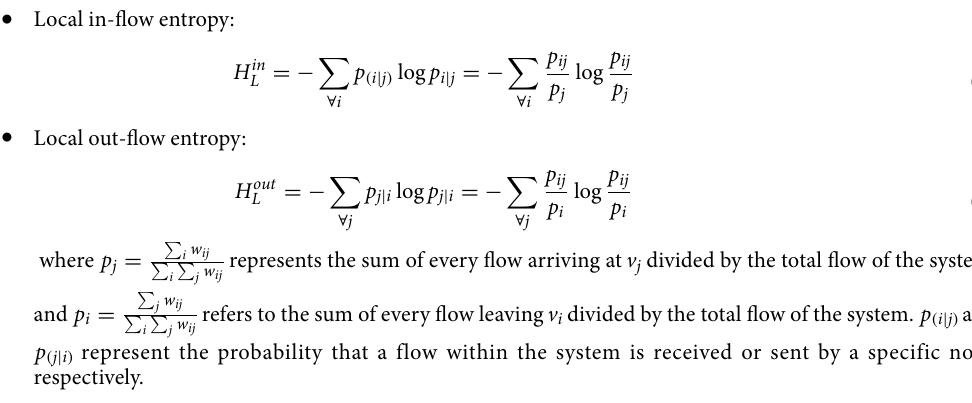
Fig. 2. Taking the common form of normalisation: H ∗∗ ( b ) = H ∗∗ ( e ) = 1 , giving the maximum value to both systems which have the same amount of existing links ( m = 10 ) and even distribution of weights. By this, we could conclude that both systems are equally diverse. However, when taking the proposed normalisation (***) the results for each systems are 1 > H ∗∗∗ ( e ) > H ∗∗∗ ( b ) . As this measure considers density, in this case none of is closer to its maximum potential, in comparison to